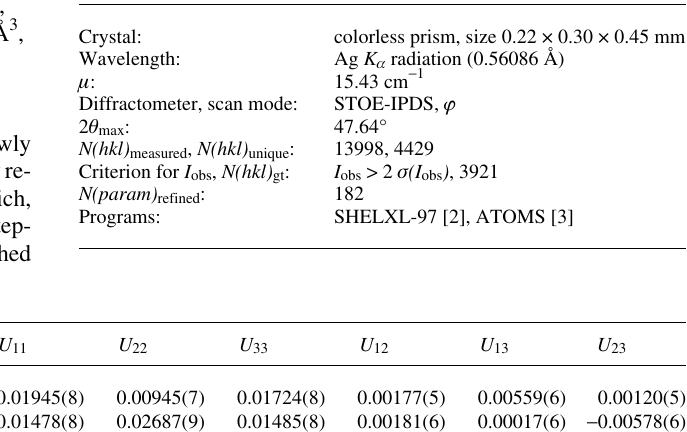
Table 1. Data collection and handling.